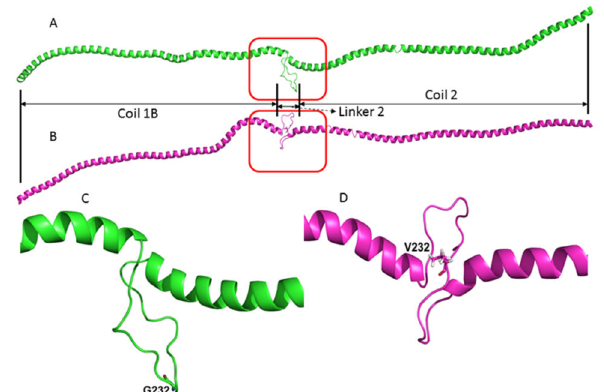
Figure 3. Structural models of LMNA. ( A ) The model of wild type LMNA (residues 81−383) was built using the HHblits-generated parameters from Modeller. ( B ) The G232V LMNA mutant model. ( C ) Higher magnification of (A). ( D ) Higher magnification of (B). G232 and V232 are shown as sticks. Modeling visualization was performed using PyMol (http://www.pymol.org).